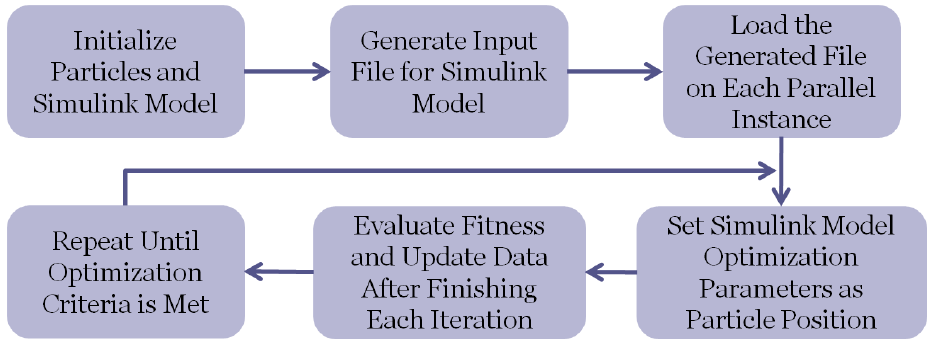
Figure 8. Parallel PSO algorithm block diagram.